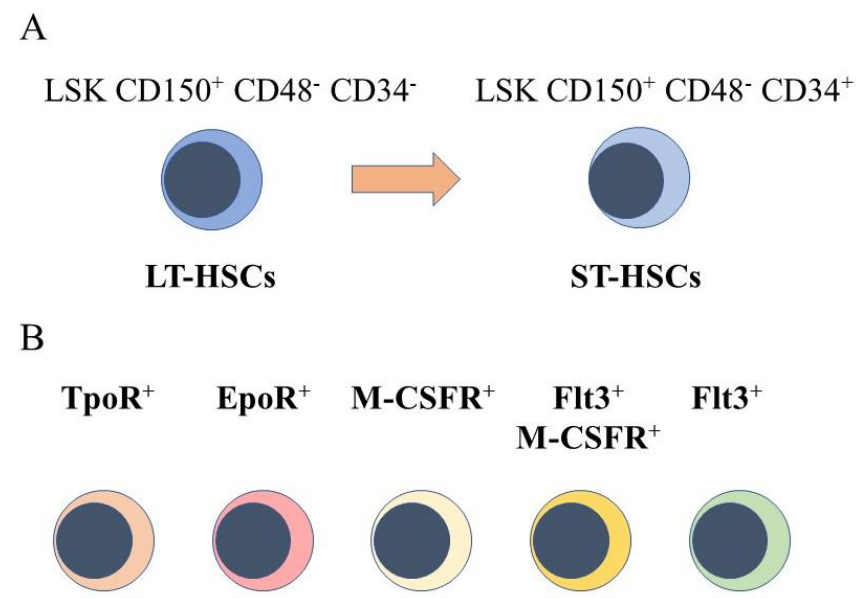
Figure 1. Murine hematopoietic stem cell populations. ( A ) mouse hematopoietic stem cells (HSCs) can be divided into cells that reconstitute severe combined immunodeficient mice long term (LT-HSCs) and short term (ST-HSC) and identified by using panels of cell surface markers. ( B ) sub-populations express the receptor for thrombopoietin at their cell surface(TpoR + ), mRNA for the receptor for erythropoietin (Epo), the cell surface receptor for macrophage colony-stimulating factor (M-CSFR + ), this receptor together with the cell surface receptor fms-like tyrosine kinase 3, and the fms-like tyrosine kinase 3.